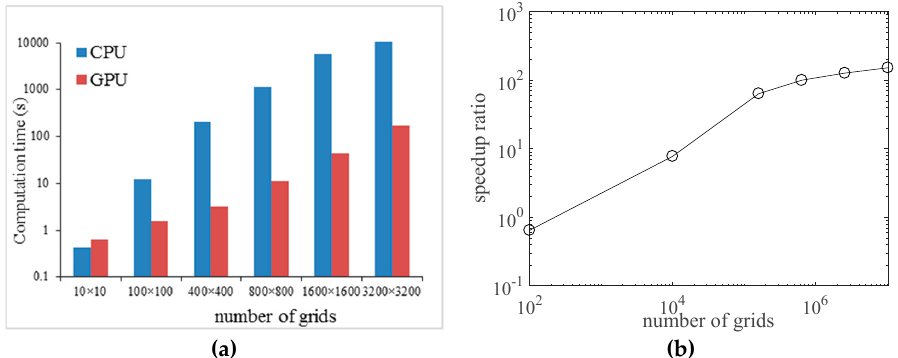
Figure 10. Performance comparison between the GPU and CPU models through ( a ) computation time